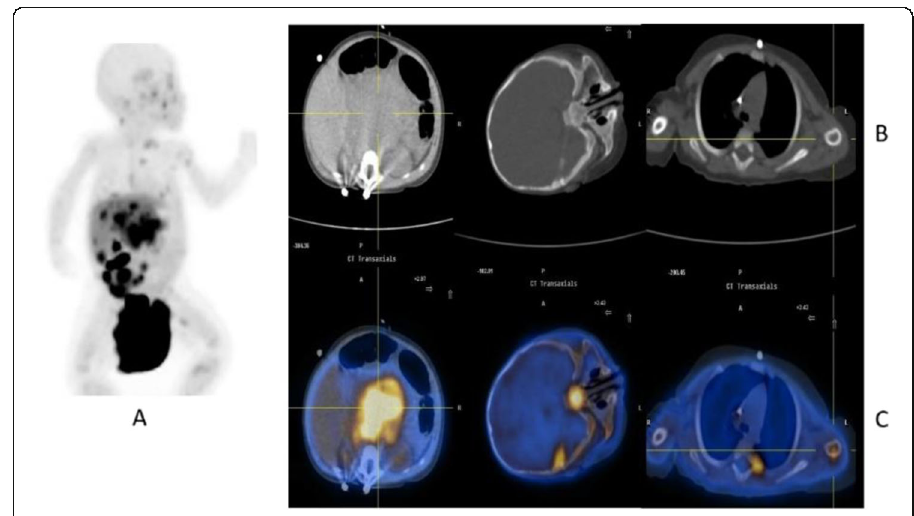
Fig. 42 18 F-FDOPA, neuroblastoma. Clinical history : 6 months old girl with neuroblastoma, stage IV at presentation. PET/CT findings : intense uptake of the tracer in multiple metastases in the liver and bones, in particular sphenoid and left humerus, seen on MIP ( a ), CT ( b ), and fused images ( c )